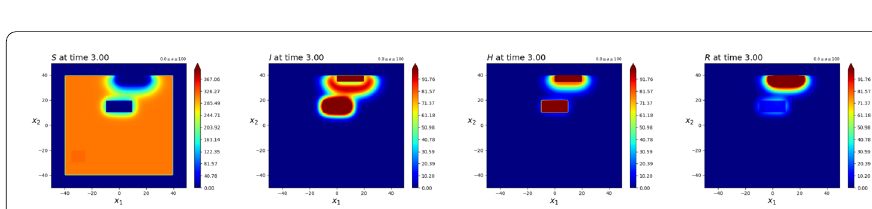
Figure 9 Contour plots of the solution to the “CareHomes” integration at time t = 3. Note the fast spreading of the disease in C 1 as defined in (12). From there, the virus spreads even faster